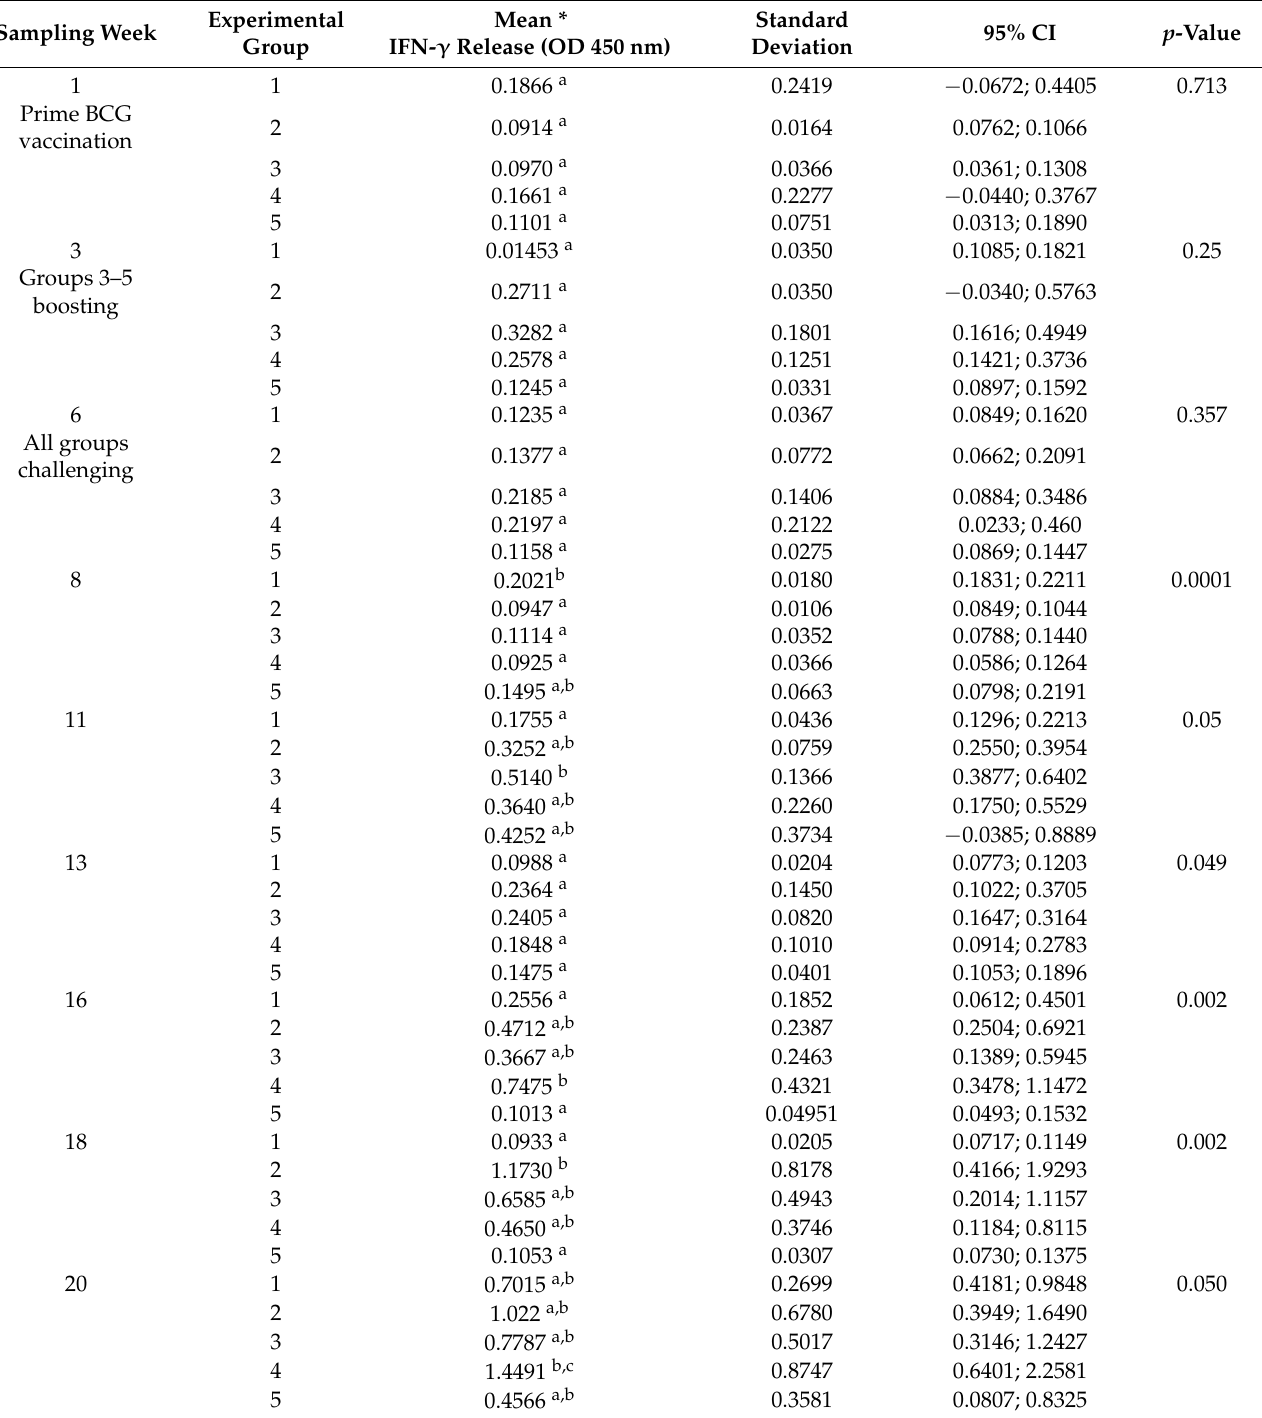
Table 3. Average, standard deviation, and 95% confidence intervals for the means of IFN- γ release for all experimental groups of goats vaccinated and challenged with a wild-type Mycobacterium bovis strain at each sampling